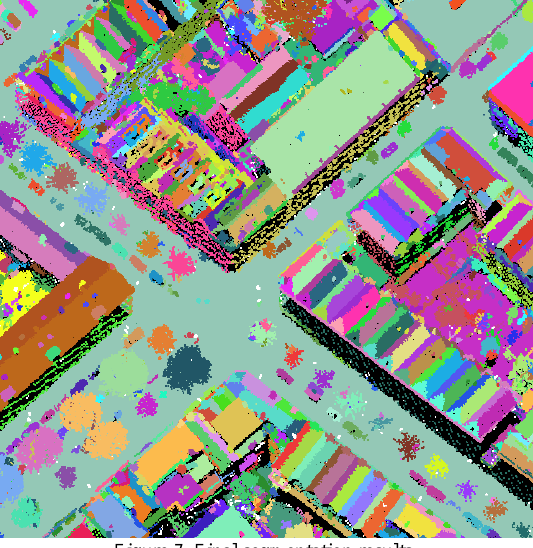
Figure 7. Final segmentation